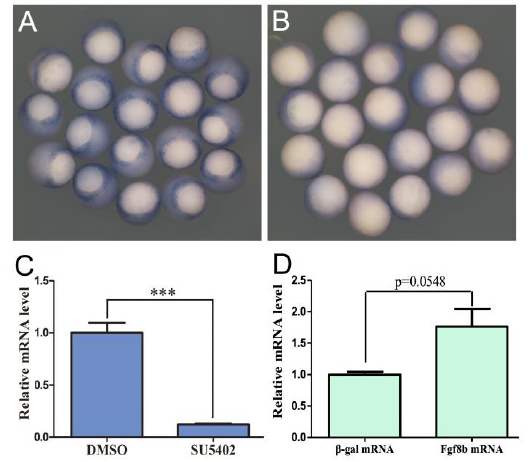
Figure 4. The mRNA expression level of Hes5.9 is regulated by the FGF (Fibroblast growth factor) signaling. The FGFR (Fibroblast growth factor receptor) inhibitor SU5402 was utilized in embryos from stage 9 (pre-gastrula stage) to stage 11 (middle gastrula stage), while the control counterparts were treated with DMSO (Dimethyl Sulfoxide). The results of whole-mount in situ hybridization displayed: compared with DMSO-treated ( A ), the Hes5.9 mRNA expression level was significantly declined by treatment with 20 µ M SU5402 ( B ). A quantitative analysis of Hes5.9 mRNA level was determined at stage 11 by RT-qPCR when the FGF signaling pathway was suppressed by SU5402 ( C ). ( D ) RT-qPCR analysis, the mRNA expression level of Hes5.9 in stage 17 when each embryo was injected with 240 pg Fgf8b mRNA at the four-cell stage, and the Hes5.9 expression was moderately increased. The values were normalized to Odc , *** p < 0.001.